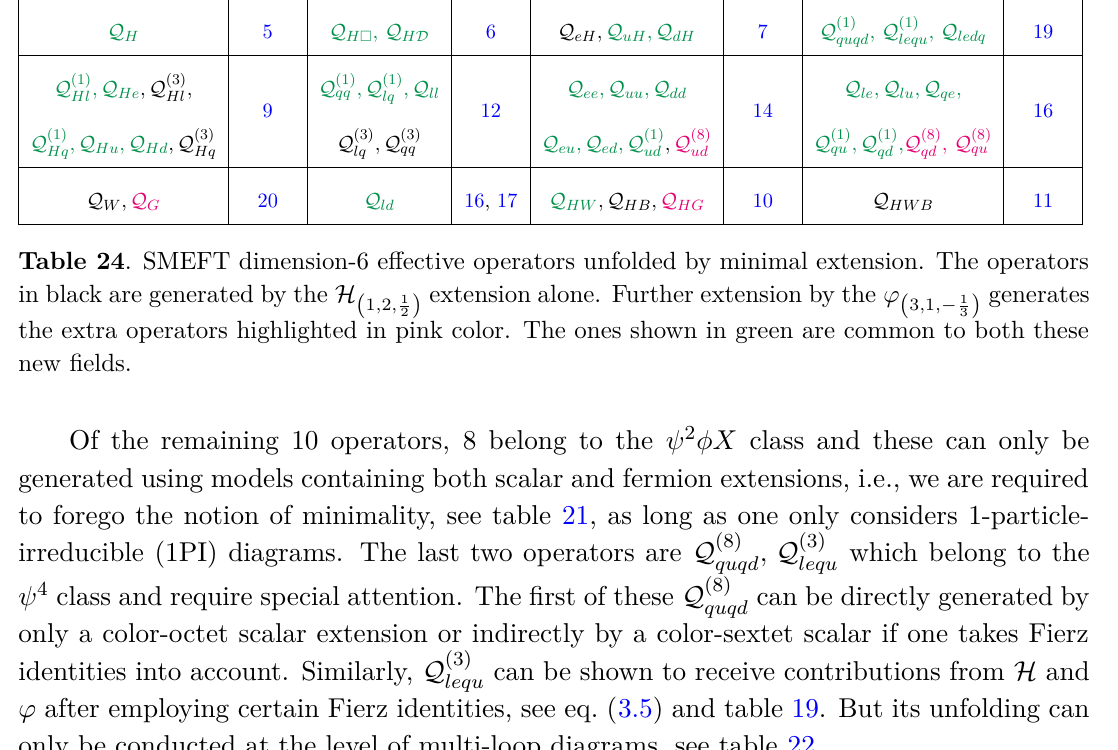
generates ( 3 , 1 , − 1 ) 3